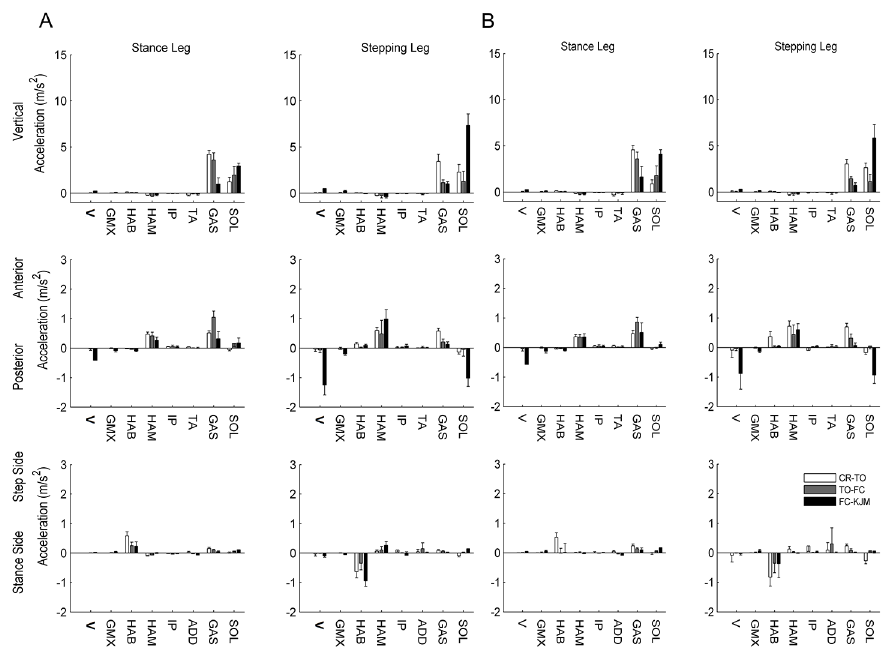
Fig 5. Mean muscle contributions to COM accelerations during balance recovery by stepping for older adults (A) and younger adults (B) from both stance side and stepping side muscles. Muscles presented are: Vasti (V), Gluteus Maximus (GMX), Hip Abductors (HAB), Hip Adductors(HAD), Hamstrings (HAM), Iliopsoas(IP) and Gastrocnemius (GAS) and Soleus(SOL). Error bars represent one standard